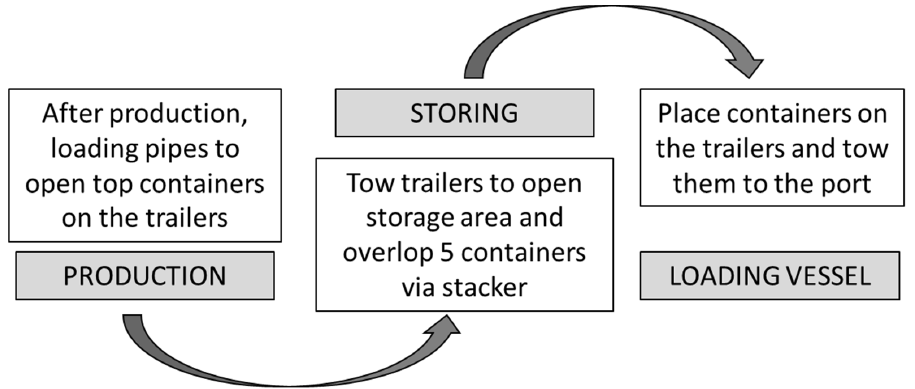
Figure 13. New logistic process steps.